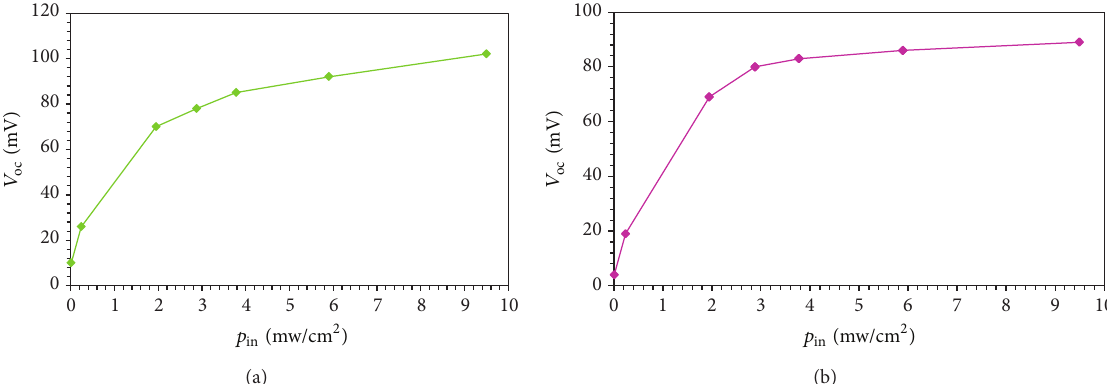
Figure 7: Open circuit voltage as a function of the incident photoenergy. (a) (n-SnO 2 /SiO 2 /n-Si) device, (b) (n-SnO 2 /SiO 2 /p-Si)